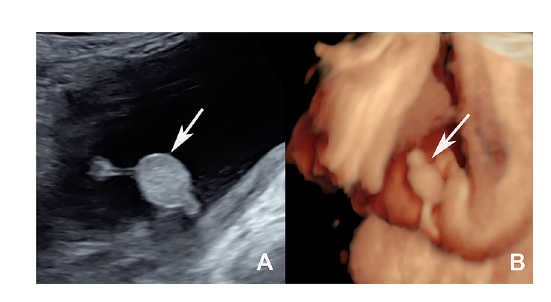
FIGURE1 (A) Two-dimensional ultrasound showed a hyperechoic mass resembling a scrotum (the white arrow shows) in the perineum of the fetus. (B) Three-dimensional ultrasound showed the scrotum-like masses (the white arrow shows) and their relationship with other organs vividly at 33 weeks gestation. and removed at the same time. Rectal duplication cysts are rare